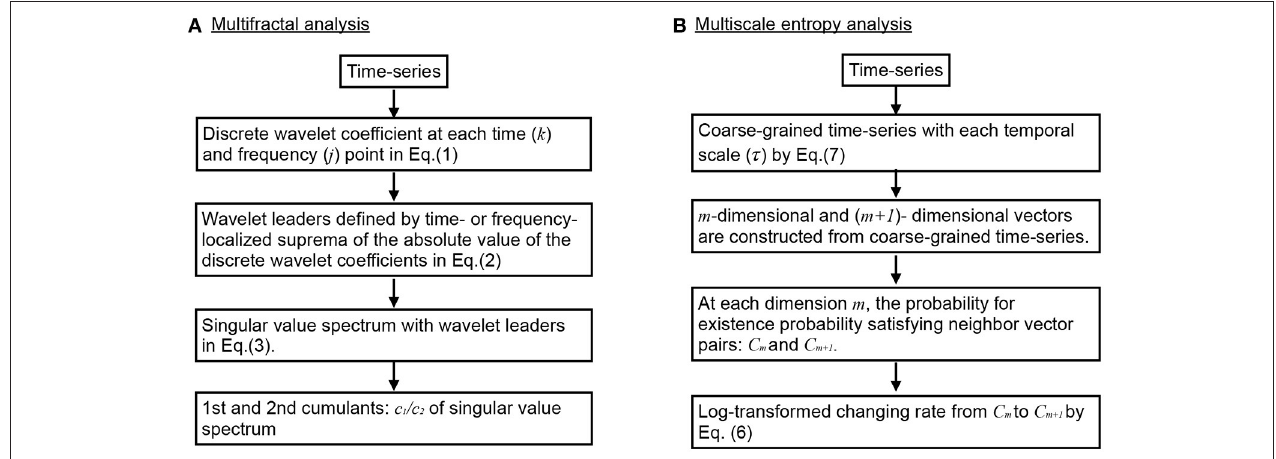
FIGURE 1 | Overview of flow for complexity analysis. (A) Multifractal (MF) analysis. (B) Multiscale entropy (MSE) analysis.